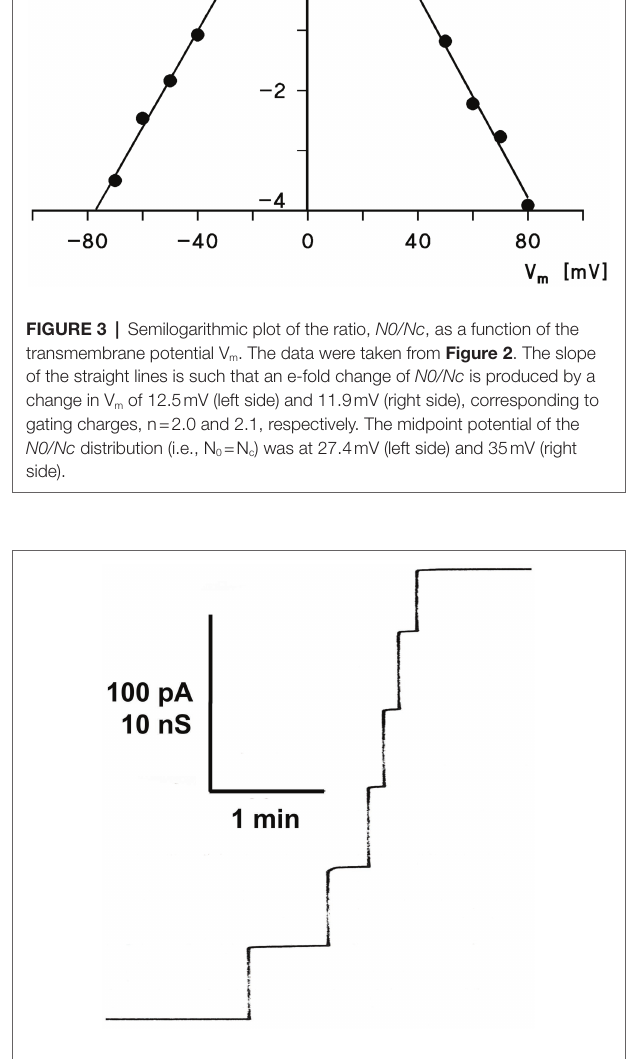
FIGURE 4 | Stepwise increase of the membrane current (given in pA) after the addition of porin 31HL (hVDAC1) to a black lipid bilayer membrane given as a function of time. The aqueous phase contained 5 ng/ml Porin 31HL and 1 M KCl (Benz et al., 1992). The membrane was formed from diphytanoyl phosphatidylcholine/n-decane. The voltage applied was 10 mV; T = 20 ° C.